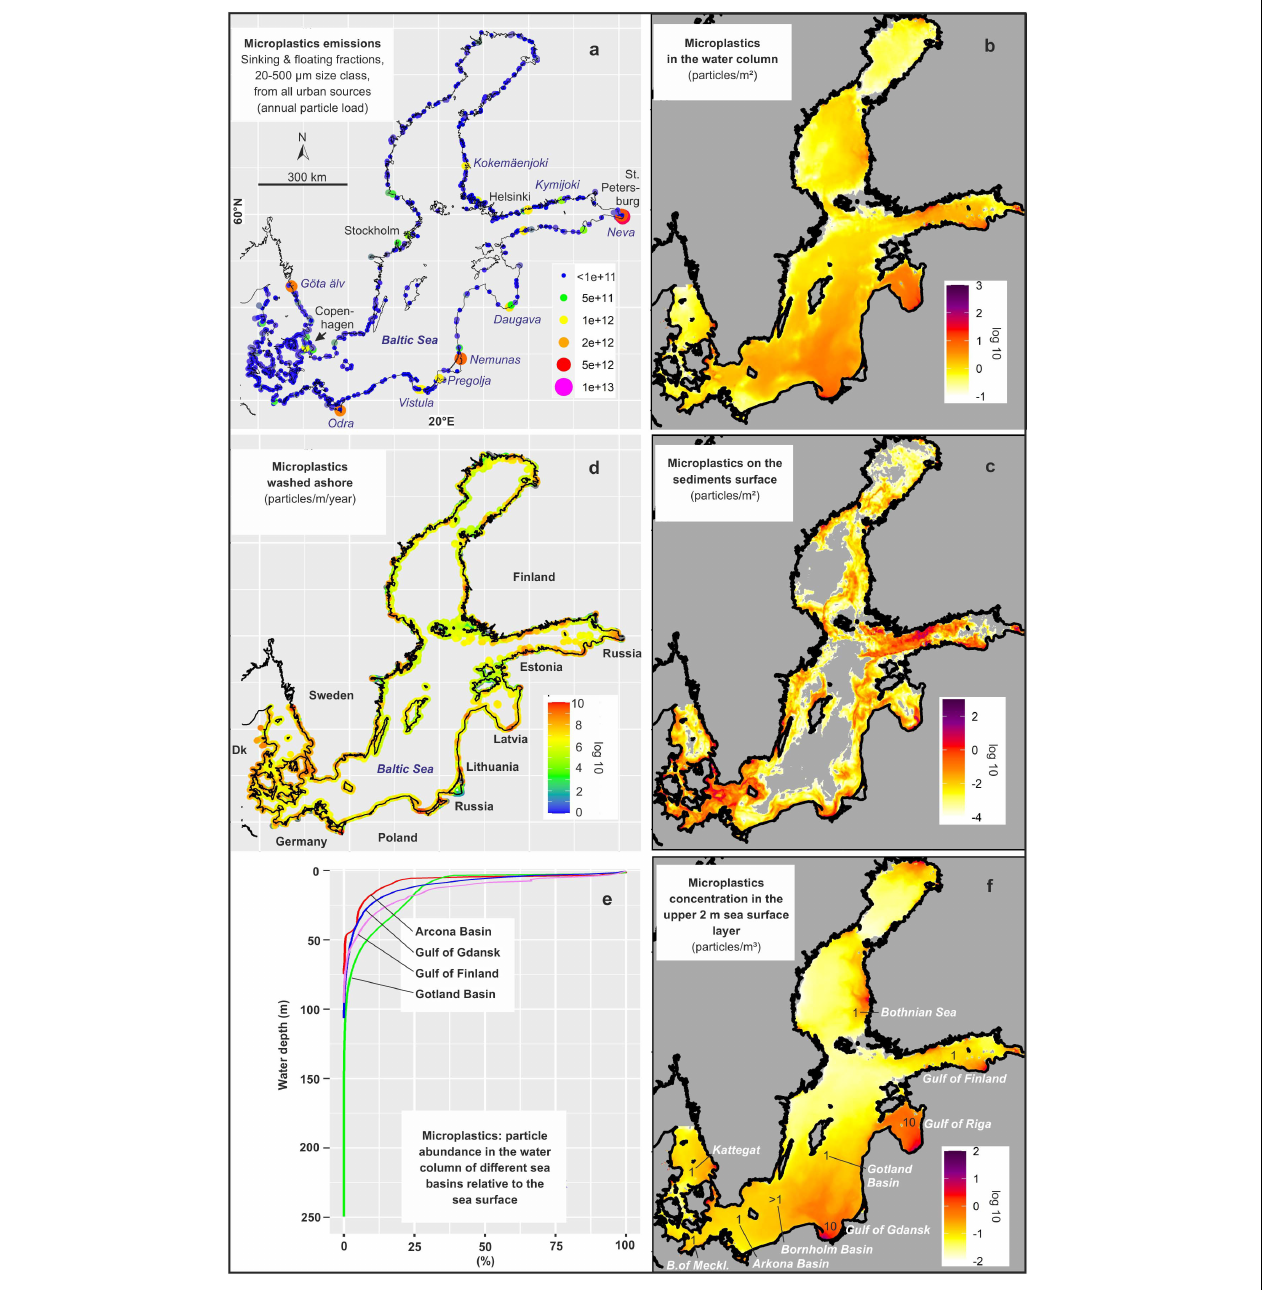
FIGURE 2 | Baltic Sea: (a) emissions of microplastic particles from all three urban sources to the Baltic Sea assuming no retention in rivers; (b) average annual spatial concentration of microplastic particles (20–500 µ m size fraction) in the water column; (c) at the sediment surface and (d) accumulation of micro-plastics microplastic particles (20–500 µ m size fraction) at Baltic Sea shores based on simulations with a 3D hydrodynamic model. Grey areas in the sea indicate concentration below the colour scale. Panel (f) shows average particle concentrations per mł in the upper 2 m of the water column and provides concrete values for major sea areas. Panel (e) visualizes the relative decreasing particle abundance (compared to the sea surface) with increasing water depth in different sea